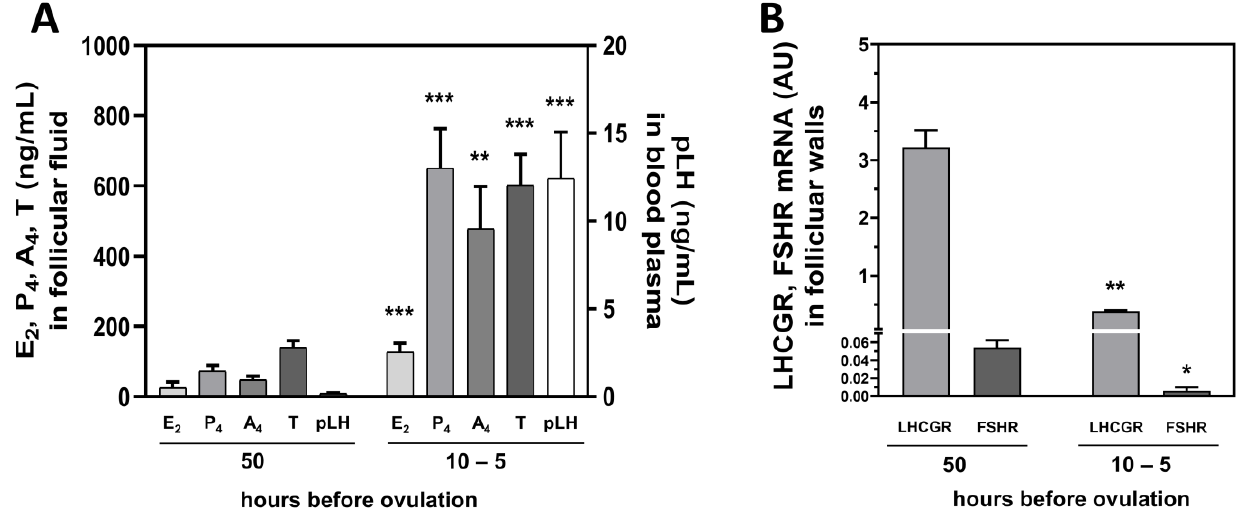
Figure 7. Hormonal milieu and dynamics of LHCGR and FSHR levels in follicular walls before ovulation. Concentrations of E2, P4, A4 and T in follicular fluid and pLH in blood plasma 50 and 10 to 5 h before ovulation ( A ). Expression of LHCGR and FSHR mRNA in preovulatory follicles walls 50 and 10 to 5 h before ovulation ( B ). * p < 0.05; * * p < 0.001; ** * p < 0.0001 for hormones/receptors at 50 h vs. 10-5 h before ovulation (Student’s t -test). AU—arbitrary units.